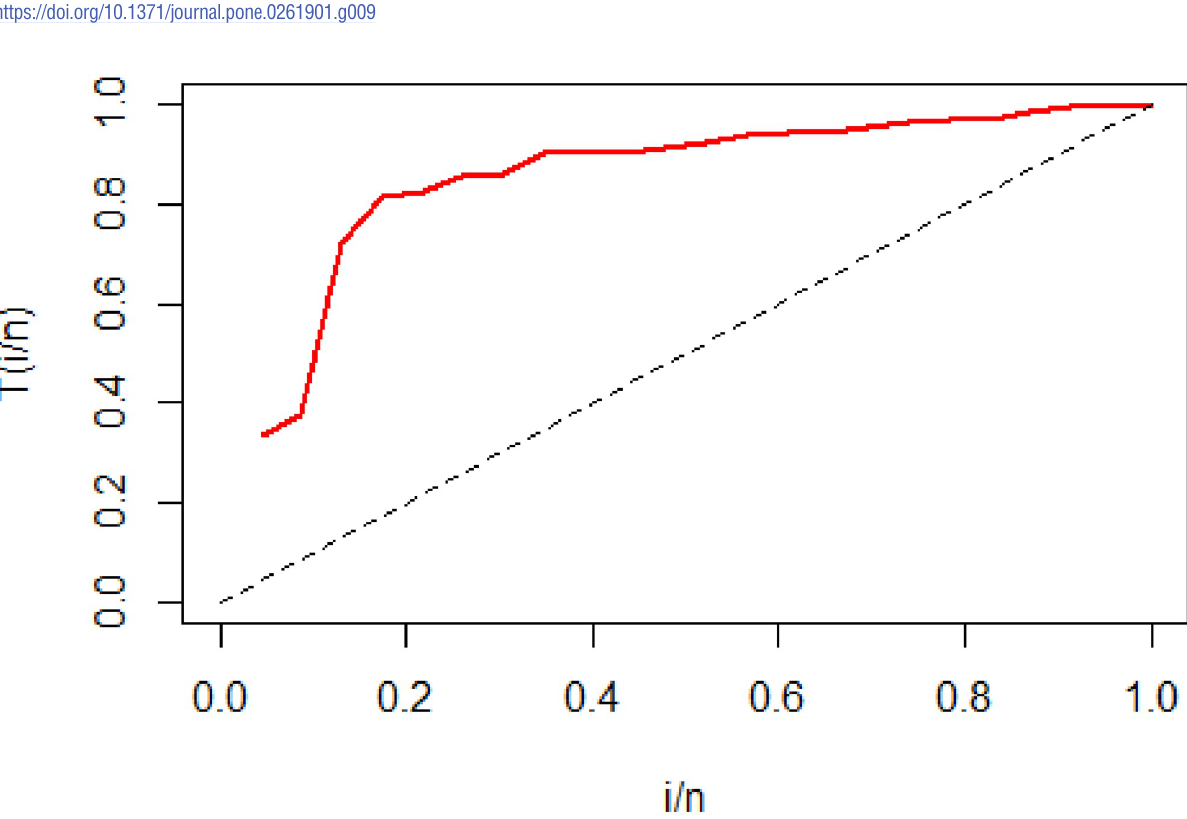
Fig 9. A:Fitting of hcMB − III distribution with different Estimation Methods. B: Behavior of selected estimation methods for hcMB − III distribution.